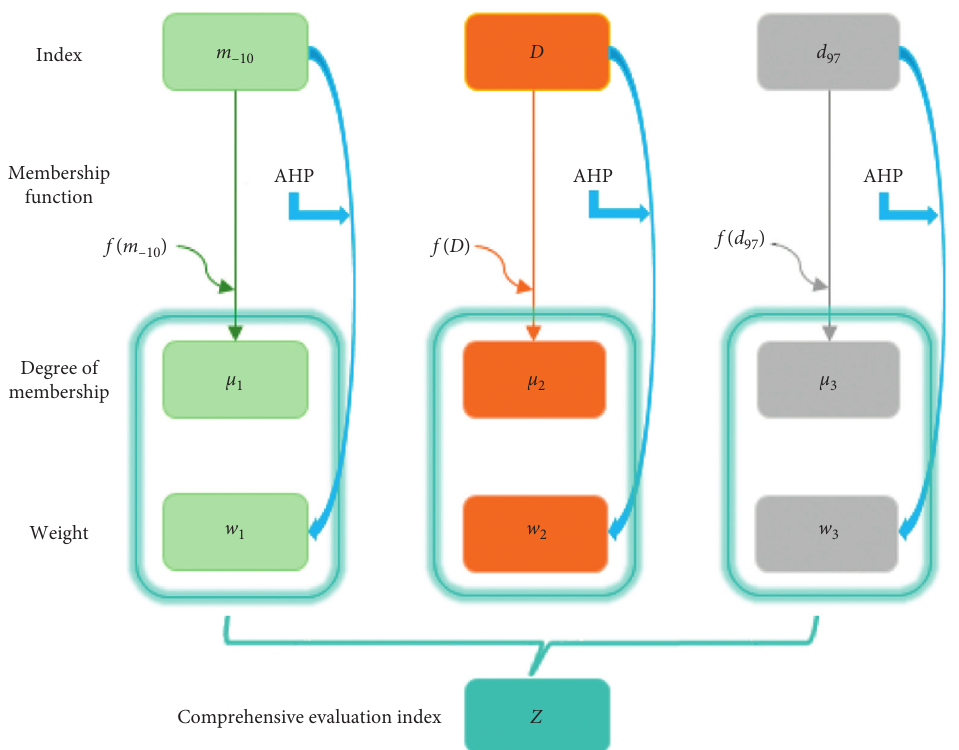
Figure 1: Flow chart of fuzzy comprehensive